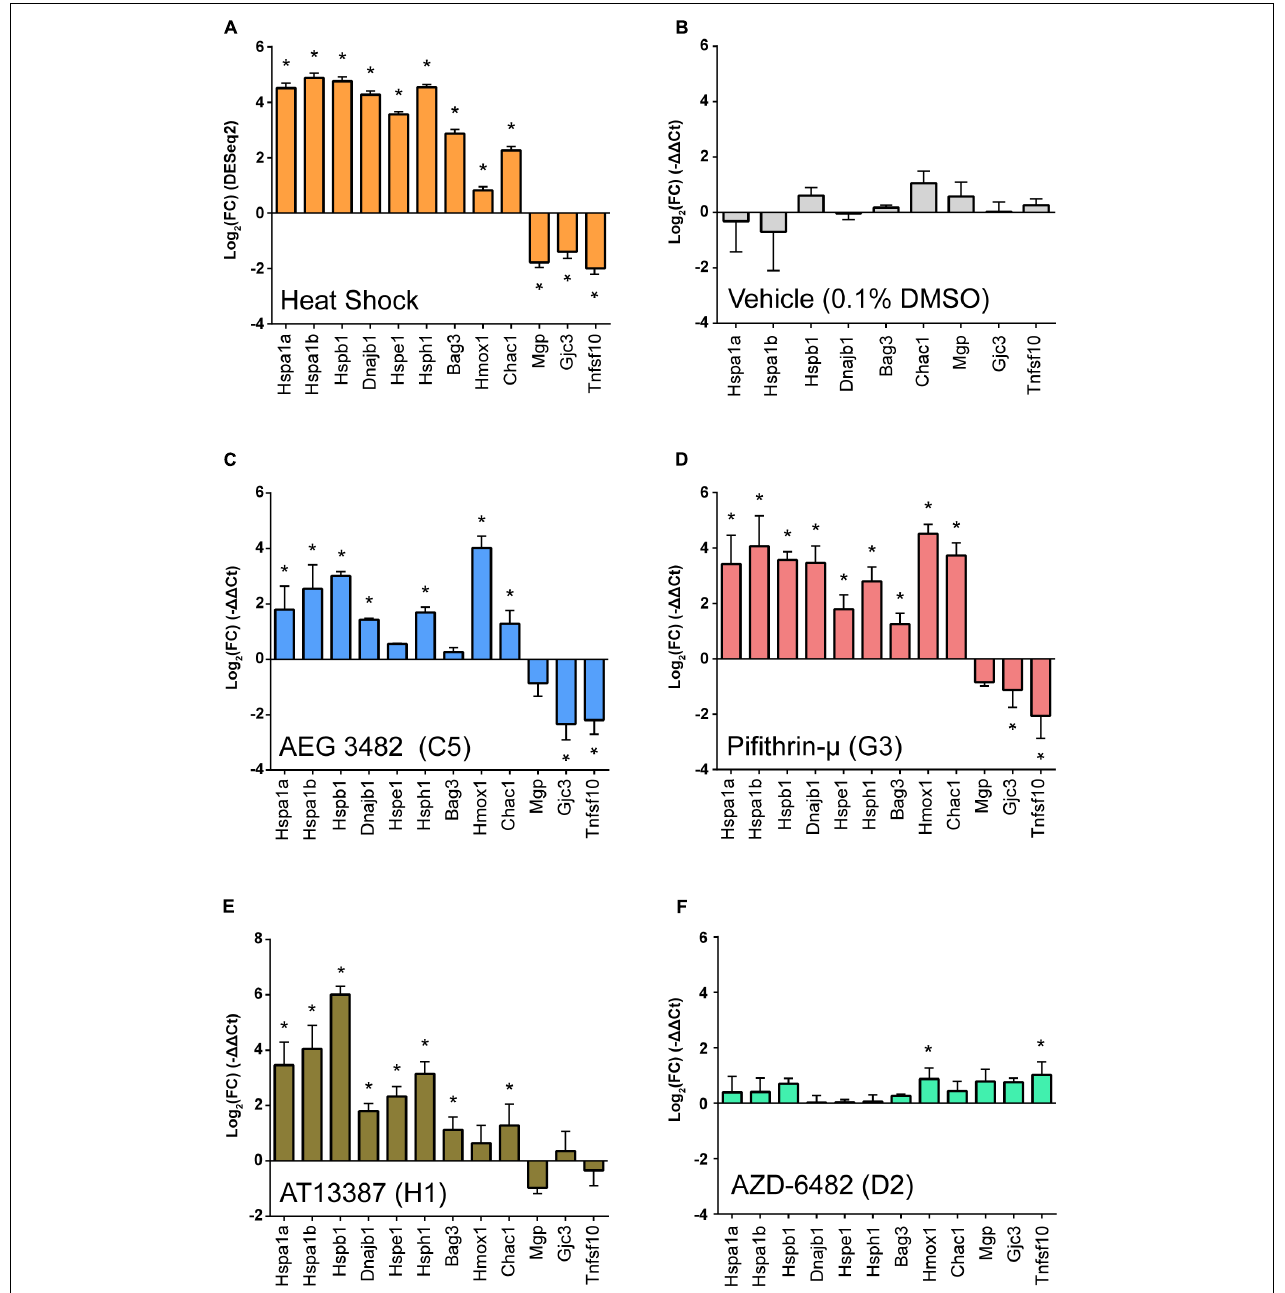
FIGURE 6 | The perturbagen hits induce the heat shock transcriptional signature in cultured mouse utricles. Gene signature profiling was performed using Taqman qPCR assays. (A) The heat shock transcriptional profile. Shown are log 2 fold changes (from DESeq2 DEG analysis) for heat shocked utricles compared to controls. Asterisks indicate significance, and error bars are ± SE for each log 2 fold change. (B) The vehicle used for the perturbagens does not induce a heat shock transcriptional signature. Shown are log 2 fold changes ( (cid:49)(cid:49) Ct) for genes measured in utricles exposed to 0.1% DMSO vehicle compared to non-heat shocked control utricles normalized to Gapdh using the Biomark HD platform. (C–F) Examination of the transcriptional signatures induced by three perturbagen hits and one reverse hit. Gene expression was measured in seven enriched and three depleted DEGs from the RNA-Seq DEG signature validation in Figure 2 in addition to two additional genes, Hmox1 and Hspe1 on the Applied Biosystems platform. (C) AEG 3482 induces the heat shock transcriptional signature in utricles. Shown are log 2 fold changes ( (cid:49)(cid:49) Ct) in utricles treated with AEG3482 (25 µ M) normalized to Actb. (D) Pifithrin- µ induces the heat shock transcriptional signature in utricles. Shown are log 2 fold changes ( (cid:49)(cid:49) Ct) in utricles treated with pifithrin- µ compared to vehicle. (E) AT-13387 induces the heat shock transcriptional signature in utricles. Shown are log 2 fold changes ( (cid:49)(cid:49) Ct) in utricles treated with AT-13387 compared to vehicle. (F) The reverse perturbagen AZD-6482 does not induce the heat shock transcriptional signature. Shown are log 2 fold changes in utricles treated with AZD-6482 compared to vehicle. Asterisks in (A–D) indicate significant ( p < 0.05) (cid:49) Ct differences compared to DMSO vehicle (cid:49) Ct values in multiple unpaired t -tests following Holm-Sidak multiple comparison correction ( n = 3 biological replicates per group).